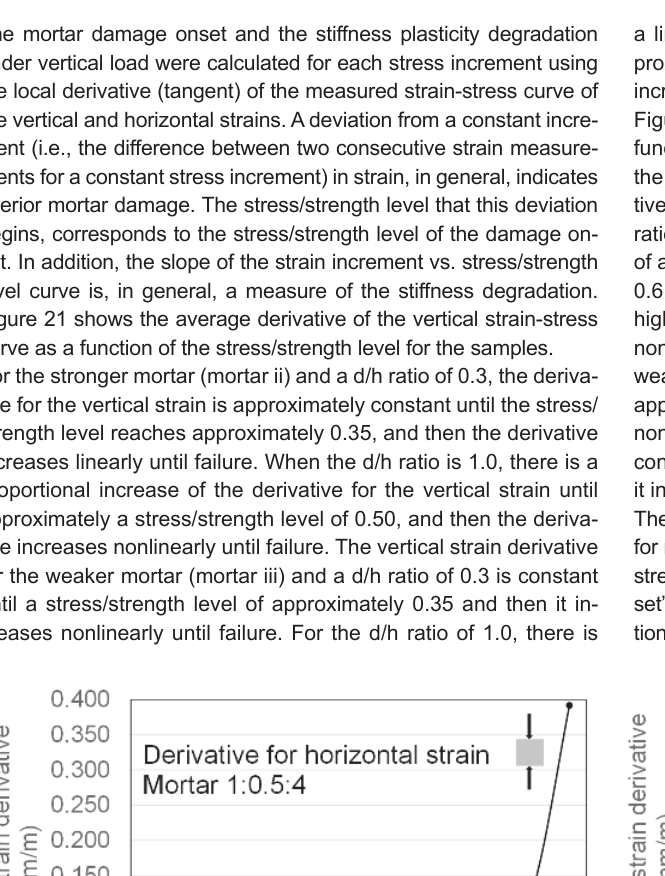
Derivative for vertical strain for different stress/strength levels